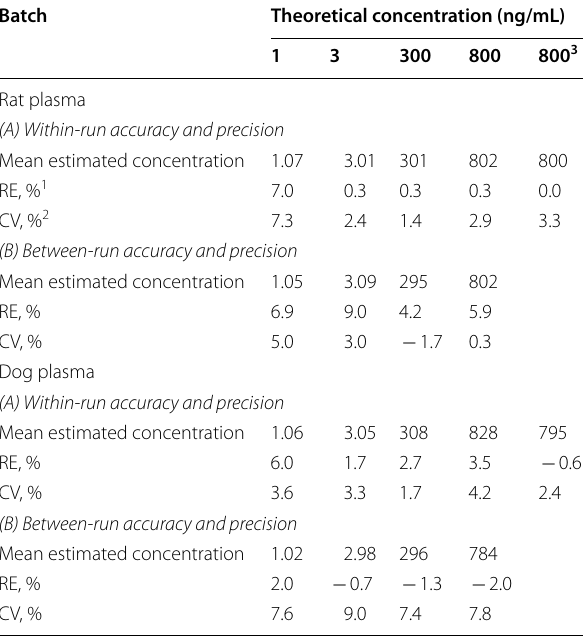
Table 2 Accuracy and precision of the assay for VEN in plasma samples from the rat and dog Table 3 Matrix effects for VEN and IS in plasma samples of the